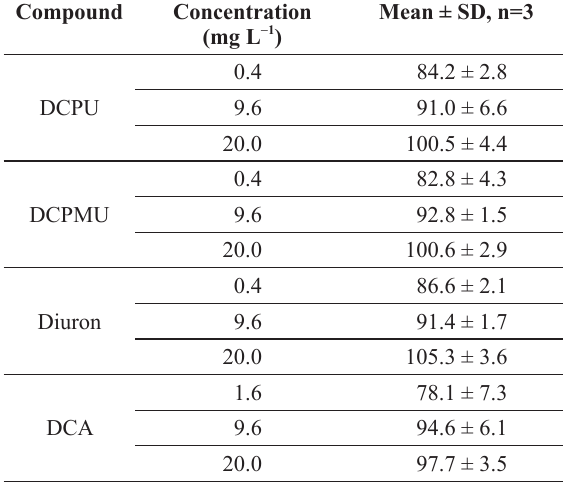
Accuracy given by recovery of the proposed method for different levels of analyte